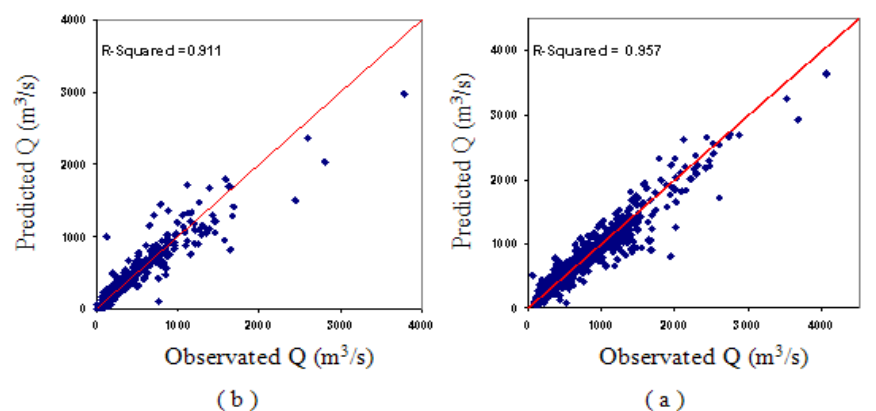
Fig 6. Observed discharge versus predicted discharge for model 3: a) training data, b) testing data